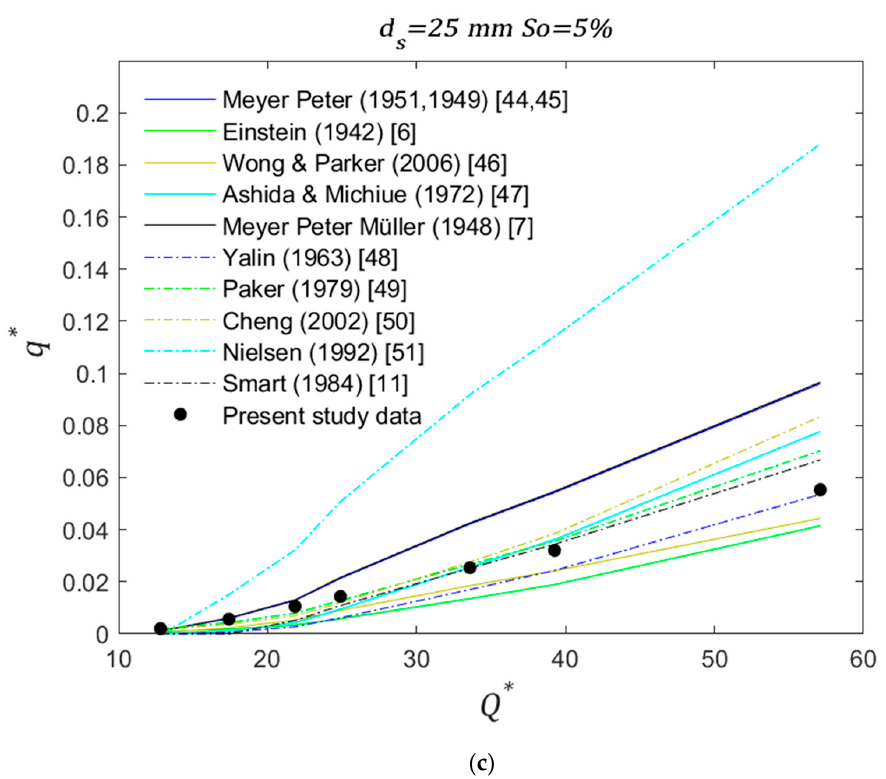
Figure 6. Experimental and calculated transport rates for uniform grain sizes of ( a ) d s = 25 mm So = 3%, ( b ) d s = 25 mm So = 4%, and ( c ) d s = 25 mm So = 5%.